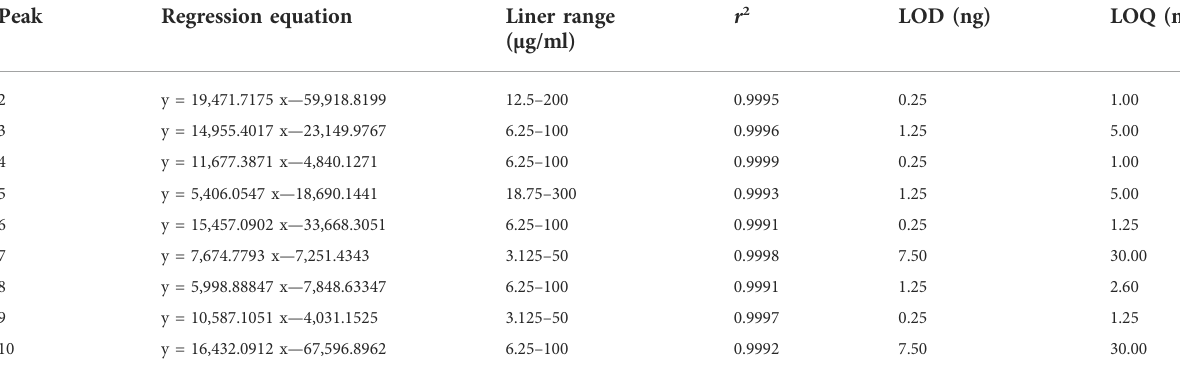
TABLE 2 Linear regression data, LOD and LOQ of nine determined analytes. Peak Regression equation